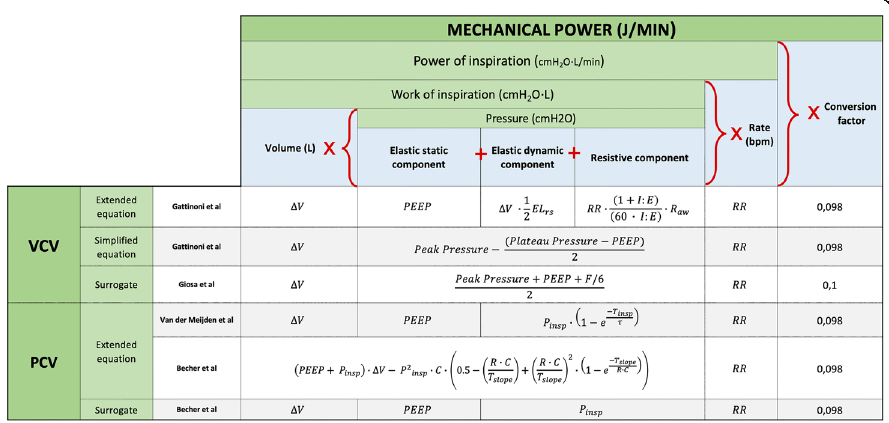
Fig. 1 Mechanical power equations for volume-controlled and pressure-controlled ventilation. Six